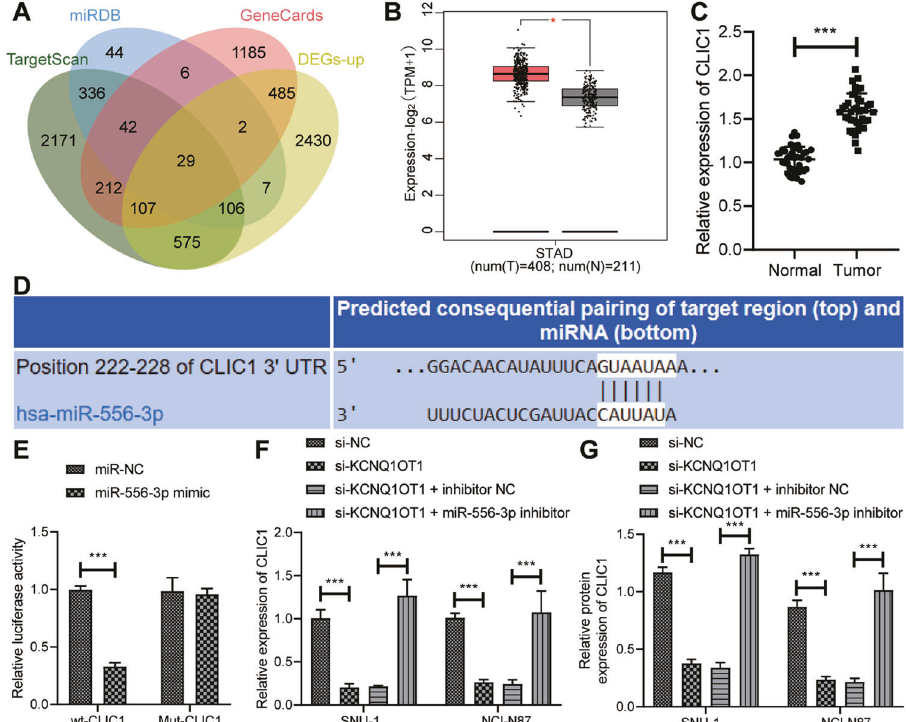
Fig. 6 KCNQ1OT1 binds to miR-556-3p to augment CLIC1 expression in GC cells. A Venn diagram of target genes of miR-556-3p in TargetScan (http://www.targetscan.org/vert_72/) and miRDB (http://www.mirdb.org/), GC-related genes in GeneCards, and upregulated genes. B Prediction of CLIC1 expression in GC and adjacent normal tissues by GEPIA website (Red represented GC, N = 408; Gray represented adjacent normal tissues, N = 211). C, Detection of CLIC1 expression in GC and adjacent normal tissues by RT-qPCR ( N = 40). D Targetscan website predicting the binding sites of miR-556-3p and CLIC1. E Dual-luciferase reporter assay was used to verify the targeting relationship between miR-556-3p and CLIC1. F The mRNA expression of CLIC1 detected by RT-qPCR after si-KCNQ1OT1 and miR-556-3p inhibitor treatment. G Western blot was used to detect the protein expression of CLIC1 after si-KCNQ1OT1 and miR-556-3p inhibitor treatment. * represents the comparison between the two groups. * p < 0.05; ** p < 0.01; *** p < 0.001. All experiments were repeated 3 CLIC1 expression, PI3K phosphorylation, and AKT phosphoryla- tion, while miR-556-3p inhibitor triggered the opposite trends (Fig. 7A). Western blot analysis depicted reduction of phosphorylation of PI3K and AKT after miR-556-3p mimic treatment, which was counteracted by treatment with miR-556-3p mimic + oe-CLIC1 (Fig. 7B). For exploring the effect of CLIC1/PI3K/AKT axis on GC cells, AKT inhibitor LY294002 was adopted to treat GC cells while overexpressing CLIC1. Based on Western blot analysis results, phosphorylation of PI3K and AKT following CLIC1 overexpression was dramatically increased, which was memorably annulled by further LY294002 treatment (Fig. 7C). Meanwhile, augmented cell